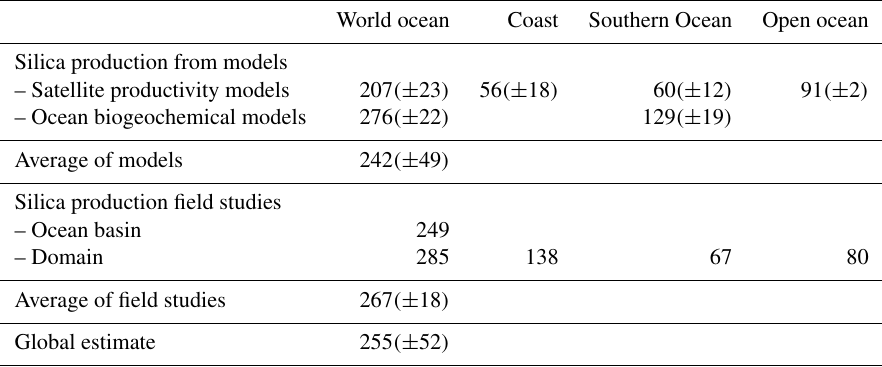
Table 2. Biological fluxes ( F Pgross inTmol Siyr − 1